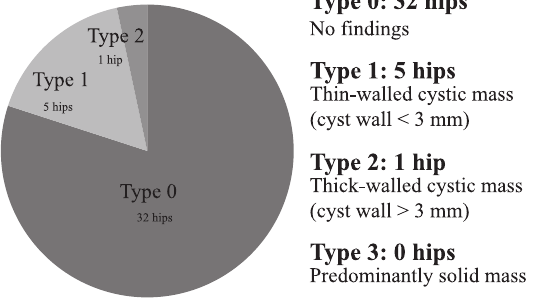
Figure 8 Magnetic resonance imaging (MRI) findings according to the Hauptfleisch classification Postoperative MRI was possible in 38 patients. According to the Hauptfleisch classification, 1 type 0 (no abnormal findings) was observed in 32 patients, type 1 (thin-walled cystic mass) in 5 patients, type 2 (thick-walled cystic mass) in 1 patient, and type 3 (a predominantly solid mass) in 0